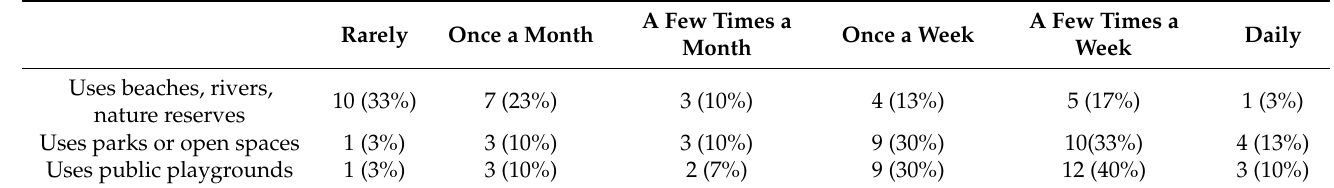
Table 4. Frequency of parent responses to Pre-PAQ questions about open space and public